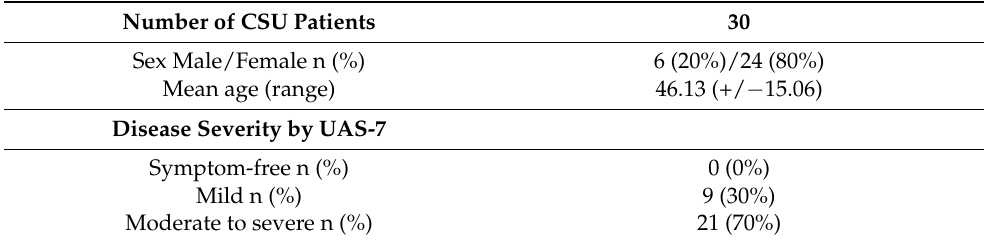
Table 1. Patients’ characteristics and disease severity. Disease severity defined as: symptom-free = complete disease control, mild = symptoms partially controlled, no need for additional therapy (UAS-7 score 7–15), moderate to severe = uncontrolled symptoms, need for additional therapy (UAS-7 score